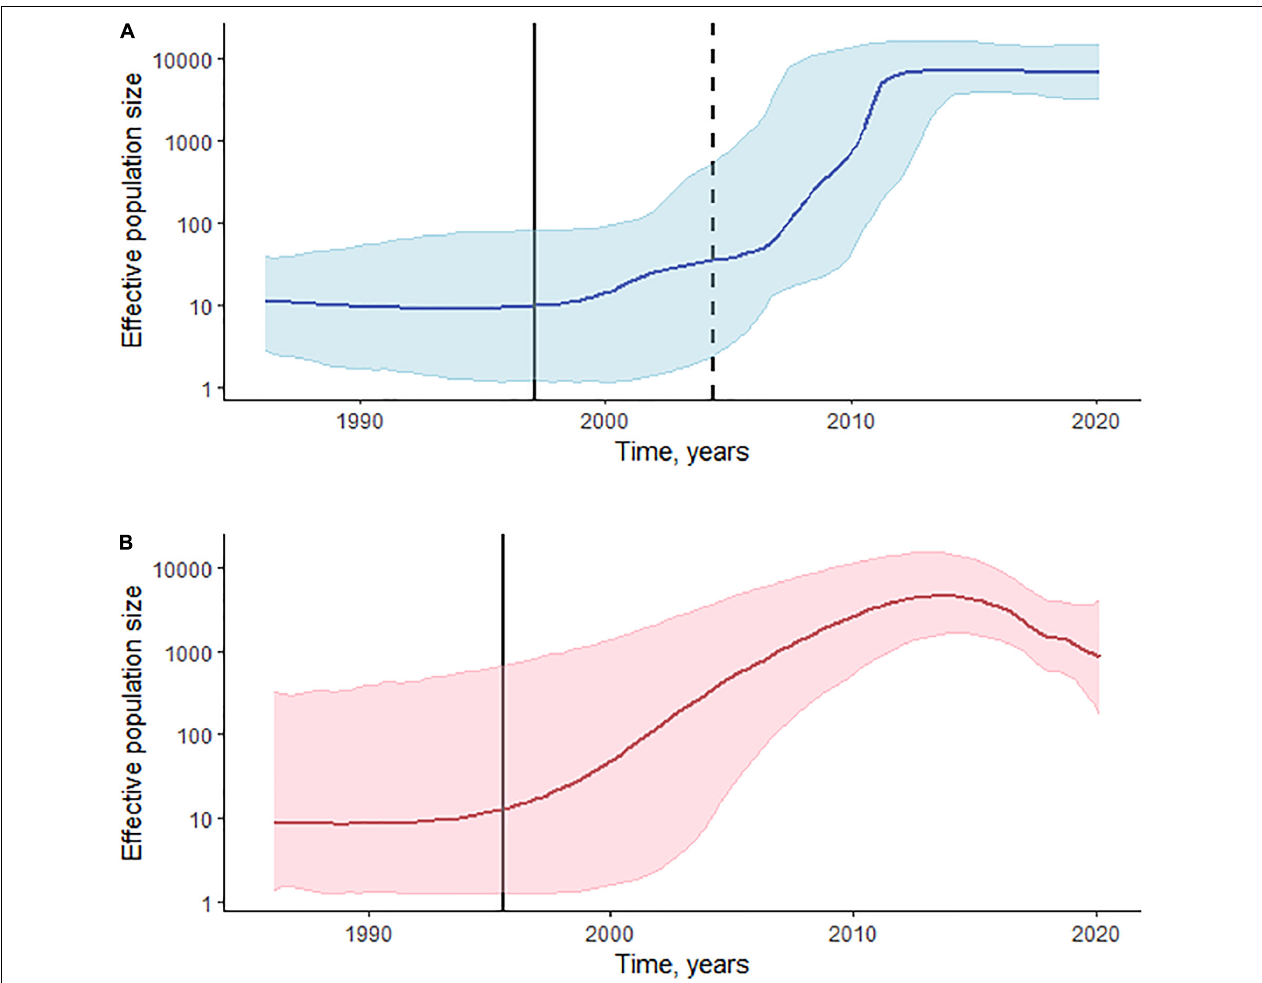
FIGURE 3 | Phylodynamic reconstruction of HIV-1 sCRF02_AG/CRF63_02A (A) and sub-subtype A6 (B) in Kyrgyzstan. (A) The Bayesian Skyline plot was reconstructed for the 325 pol gene sequences of CRF02_AG and 10 sequences of CRF63_02A. The horizontal bold line indicates effective population size through time; blue-shaded area represents the 95% highest posterior density (HPD). The vertical bold black line indicates the estimated origin date for CRF02_AG [January 1997 (95% HPD: February 1986–May 2004)]; the vertical dashed line indicates the estimated origin date for CRF63_02A [April 2004 (95% HPD: January 1997–April 2009)]. (B) The Gaussian Markov random field (GMRF) Bayesian Skyride plot was reconstructed for the 173 pol gene sequences of sub-subtype A6. The horizontal bold line indicates effective population size through time; pink-shaded area represents the 95% HPD. The vertical bold black line indicates the estimated origin date for sub-subtype A6 [June 1995 (95% HPD: August 1985–August